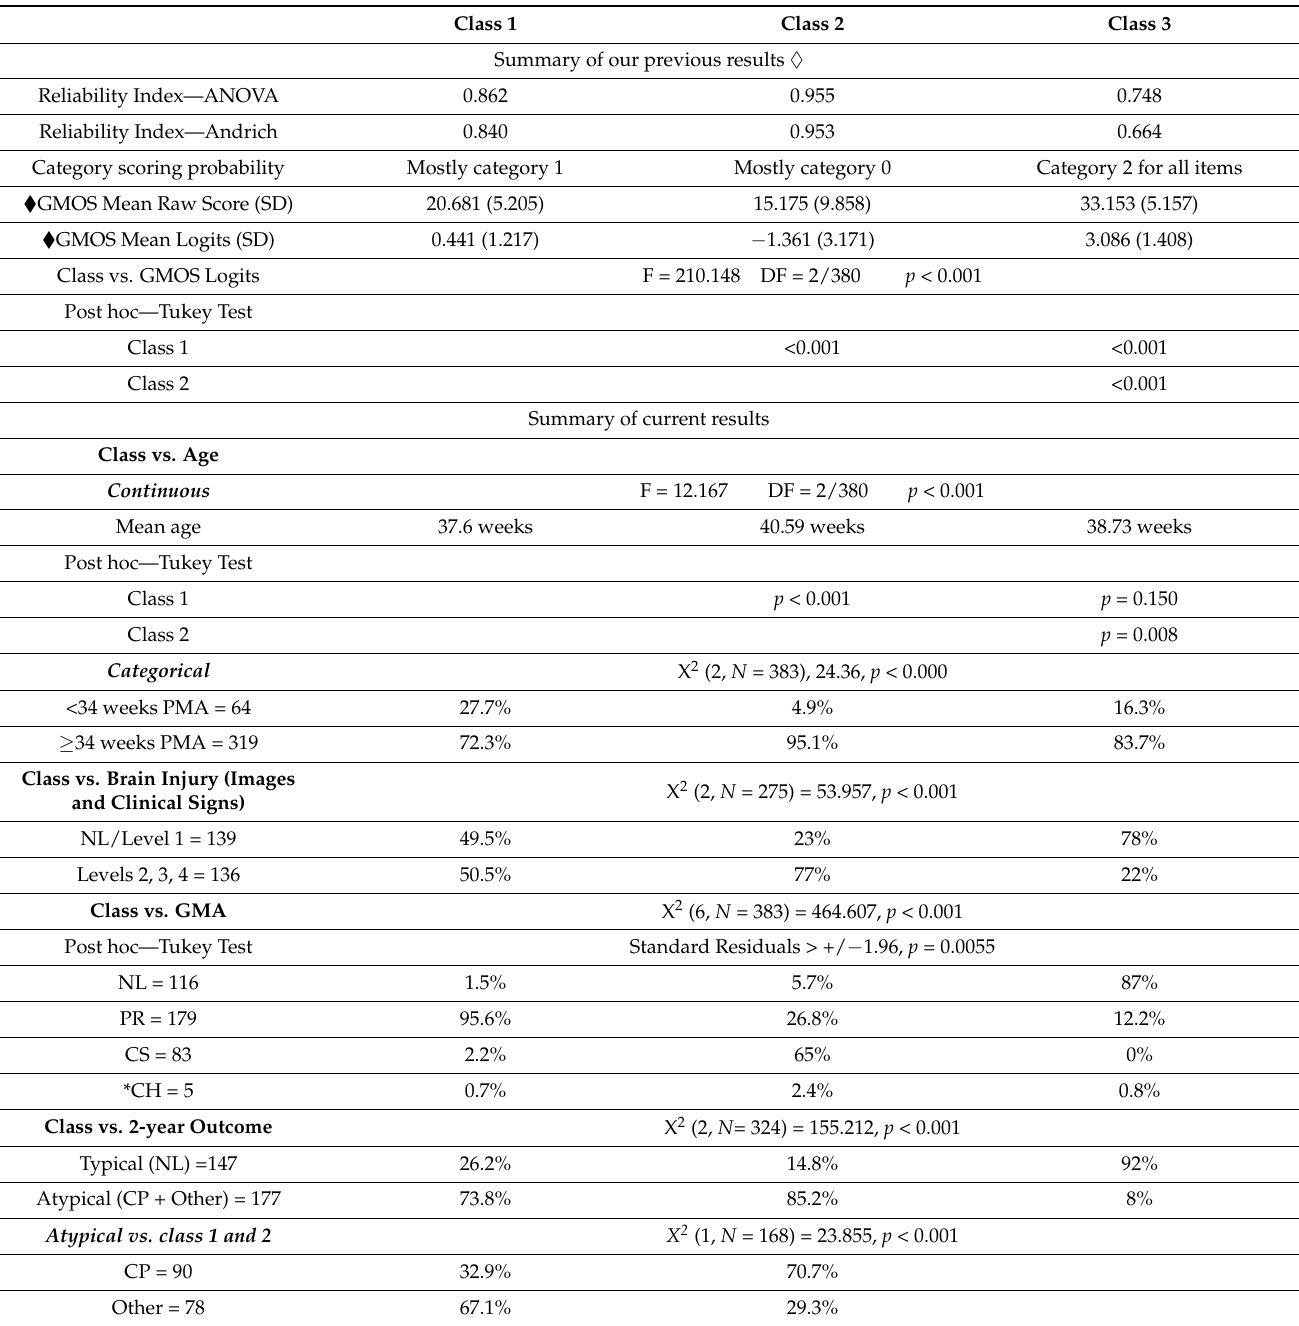
Table 2. ANOVAs and Chi-square examining the General Movement Optimality Score (GMOS) logit mean scores and class membership based on different clinical